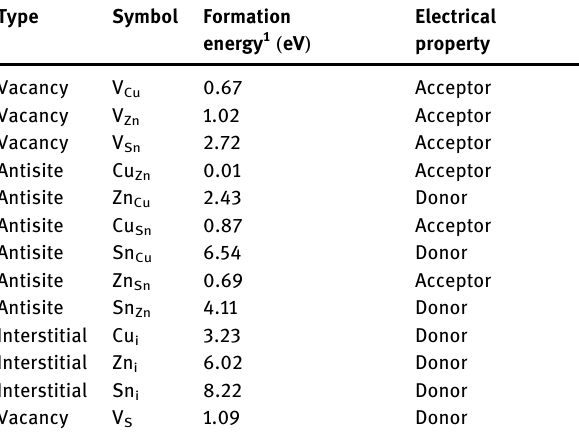
Table 1: Formation energies of point defects in CZTS determined by theoretical calculations [ 59 ]